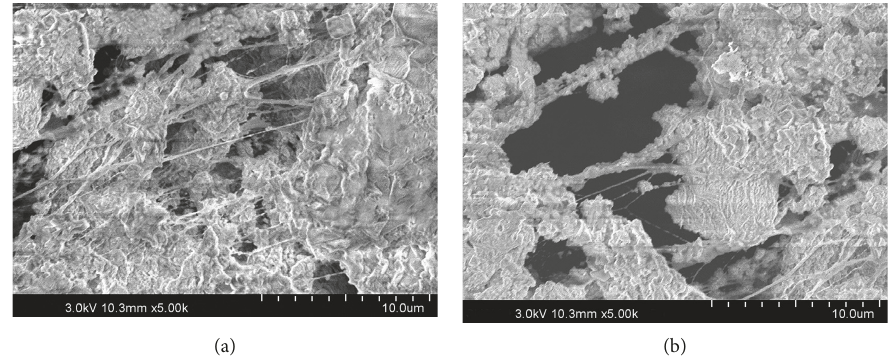
Figure 13: SEM photos of T3 cement stone specimens: (a) the overall microstructure of TPR cement stone; (b) the partial microstructure of TPR cement stone.